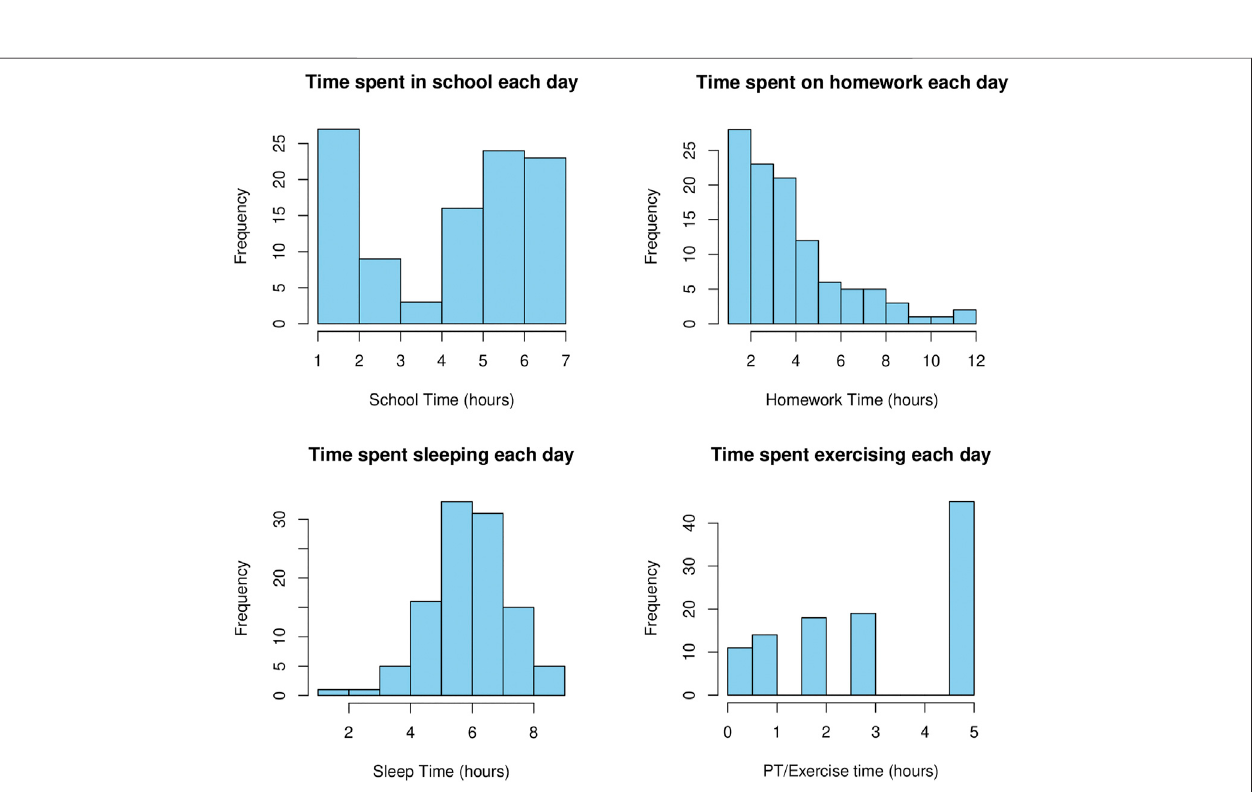
FIGURE 3 | Time distribution reported by participants for key daily